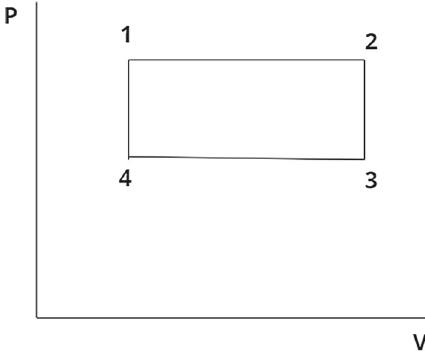
Fig. 11 A square cycle in the P – V